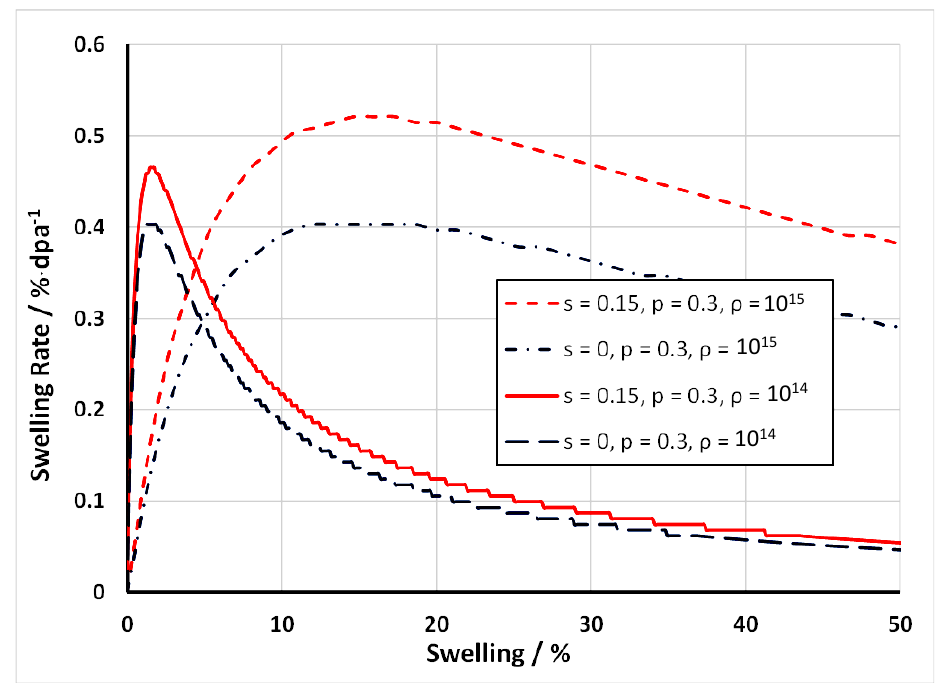
Figure 31. Swelling with (s = 0.15) and without (s = 0) stress for a dislocation density of 10 15 m −2 and of 10 14 m −2 . It is apparent that swelling is enhanced by stress/creep.